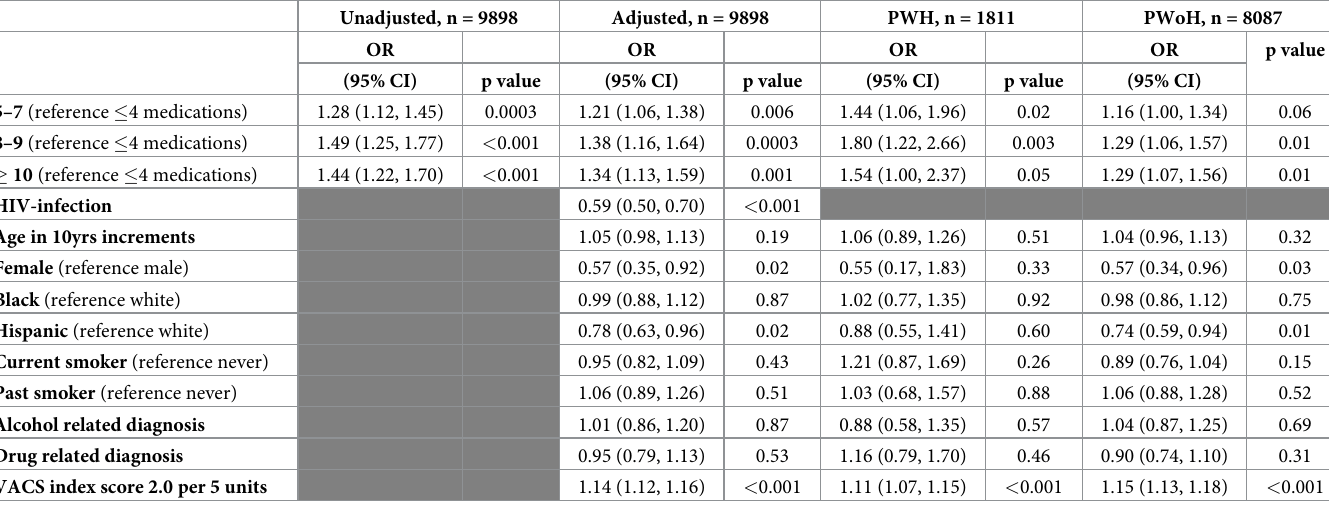
Table 3. Logistic regression models looking at increments of medication count and MICU admission. Unadjusted, n = 9898 Adjusted, n = 9898 PWH, n = 1811 PWoH, n = 8087